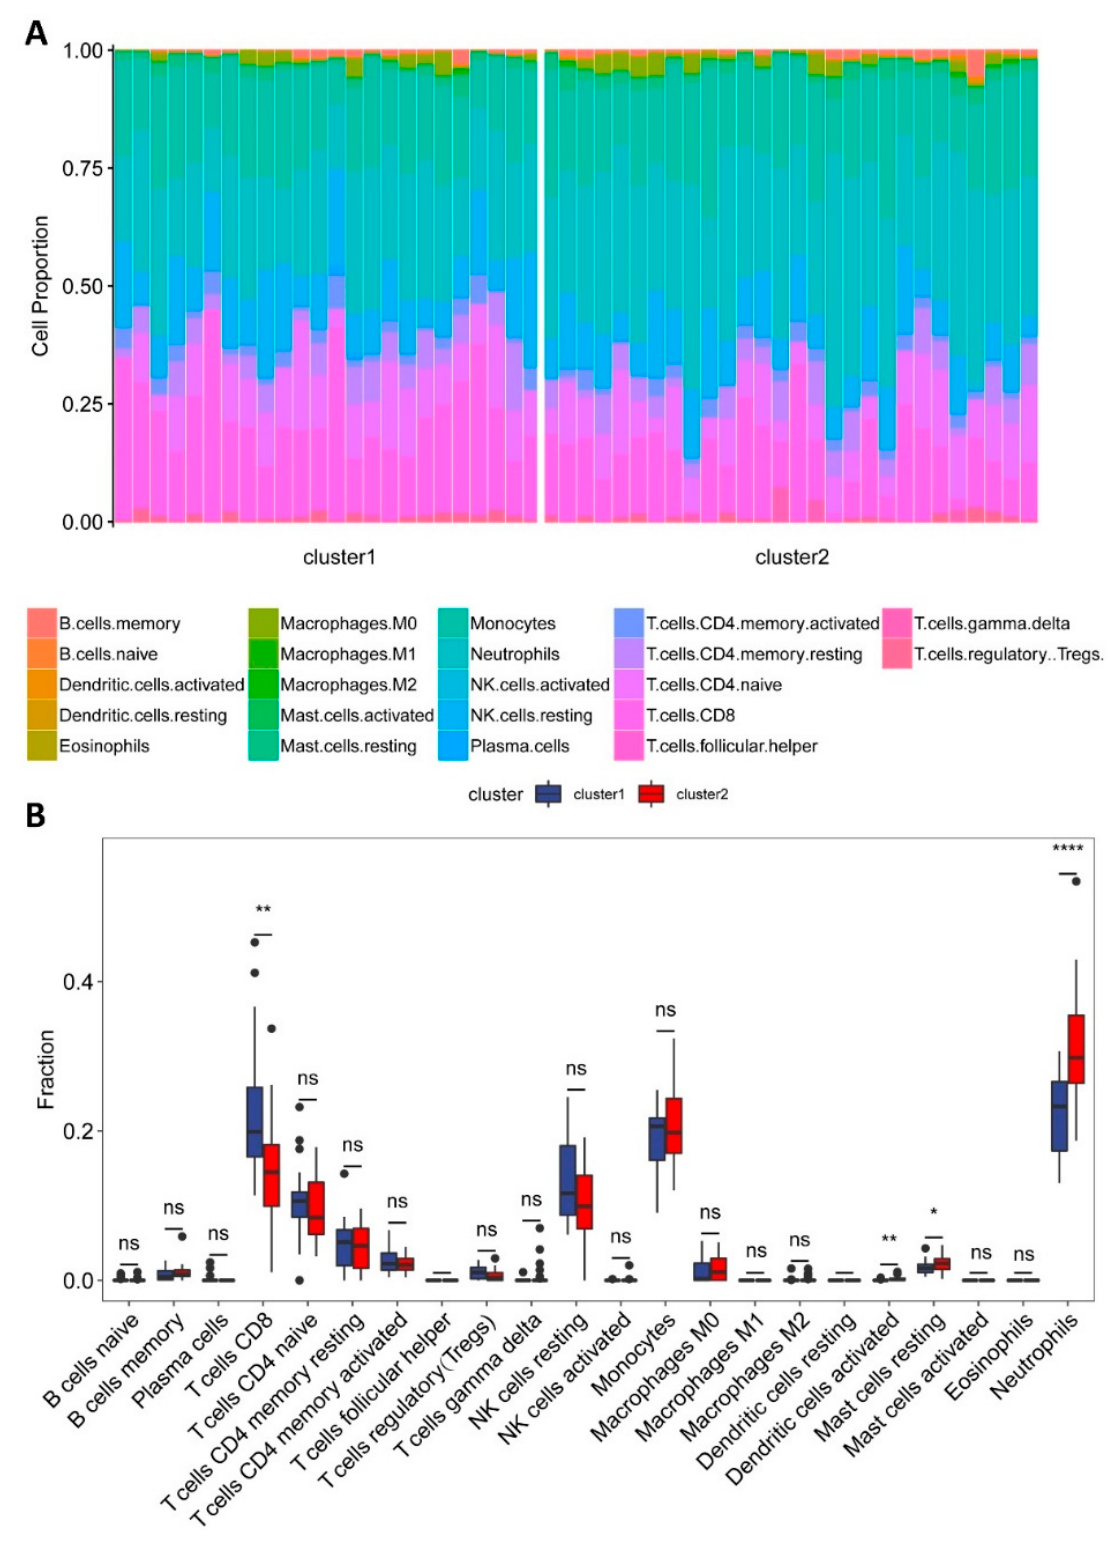
Figure 3. Immune cell type deconvolution. ( A ) Stacked bar plots showing proportions of immune cells in peripheral blood, separated by the two clusters. Each type of immune cell is represented by a different color. ( B ) Box plots illustrating differences in proportions of 22 immune cells between the two clusters. The asterisks indicate that the differences are statistically significant. * p < 0.05, ** p < 0.01, **** p < 0.0001. ns, not significant.